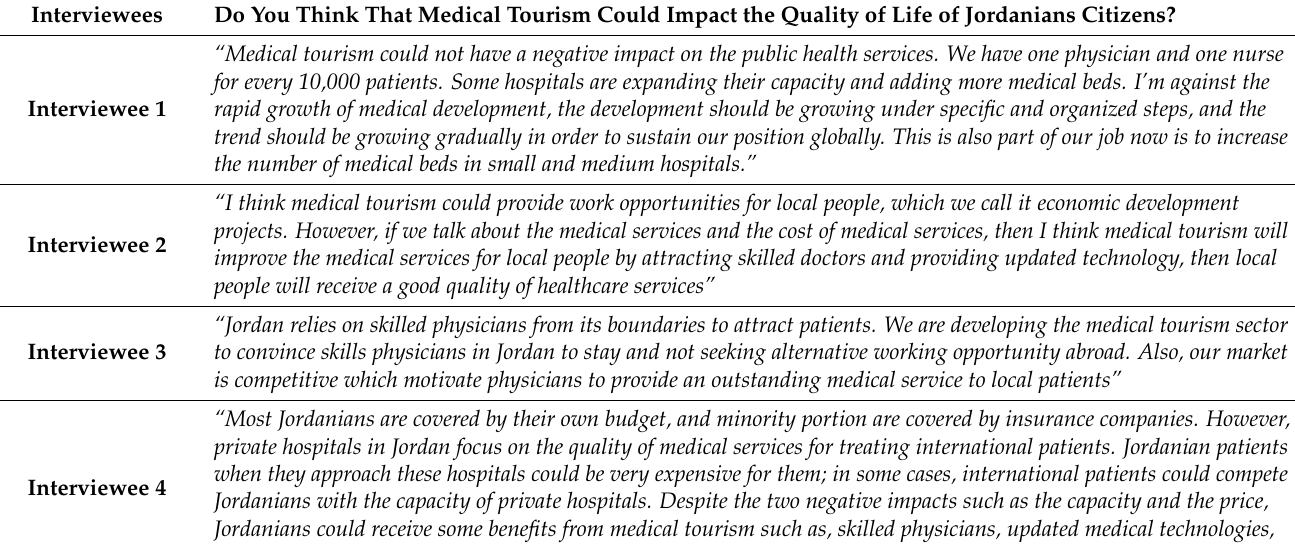
Table 6. The impact of medical tourism on the quality of life of